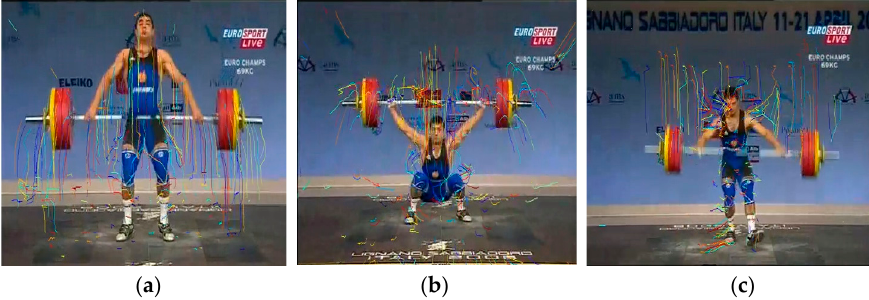
Figure 5. Dense trajectories. ( a ) Trajectory at frame 310, ( b ) trajectory at frame 430, ( c ) trajectory at frame 700.